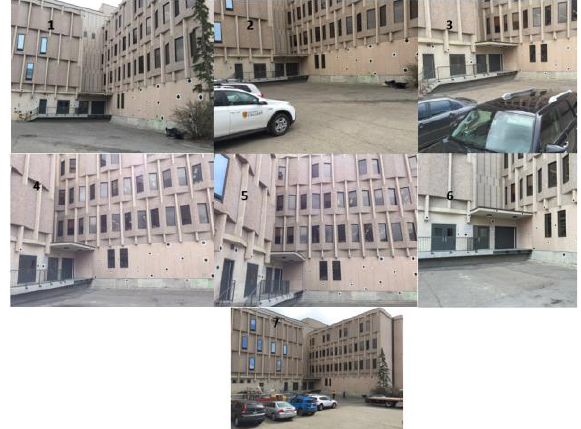
Figure 8. Captured overlapped images using IPhone6’s camera